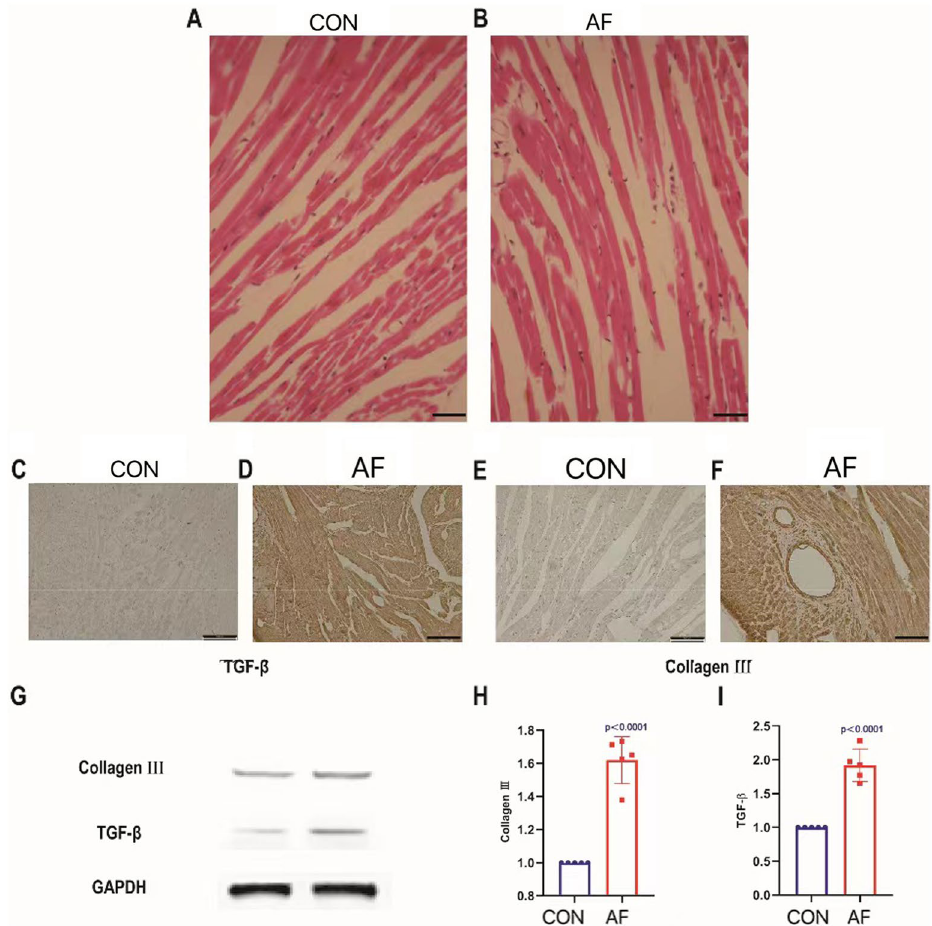
Figure 1. The inflammatory response and collagen production of atrial myocytes were increased in the CG induced atrial fibrillation model group. ( A ) Atrial myocytes histopathologic change in CON was observed by hematoxylin and eosin (HE) staining. ( B ) Atrial myocytes histopathologic change in AF was observed by HE staining. ( C ) TGF-β expression in atrial myocytes in CON was detected by immunohistochemistry. ( D ) TGF-β expression in atrial myocytes in AF was detected by immunohistochemistry. ( E ) Collagen III expression in atrial myocytes in CON was detected by immunohistochemistry. ( F ) Collagen III expression in atrial myocytes in AF was detected by immunohistochemistry. ( G ) Results of Western blotting detecting Collagen III and TGF-β expressions in atrial myocytes in CON and AF. ( H ) Comparison of the expression of Collagen III in atrial myocytes in CON and AF. ( I ) Comparison of the expression of TGF-β in atrial myocytes in CON and AF.